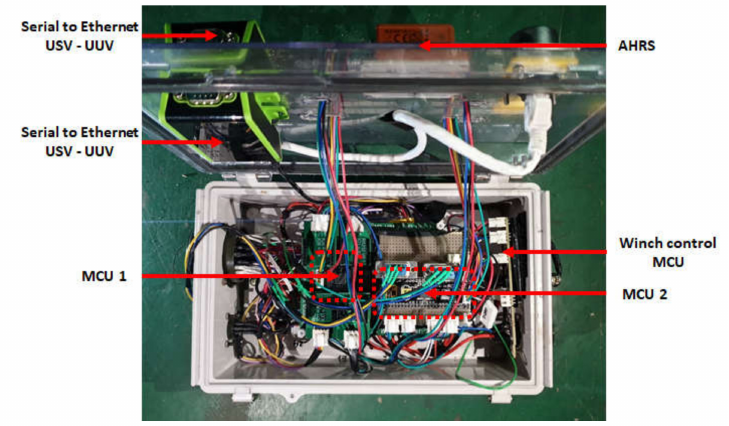
Figure 11. Control module of USV. AHRS, attitude heading reference system; MCU, micro processing